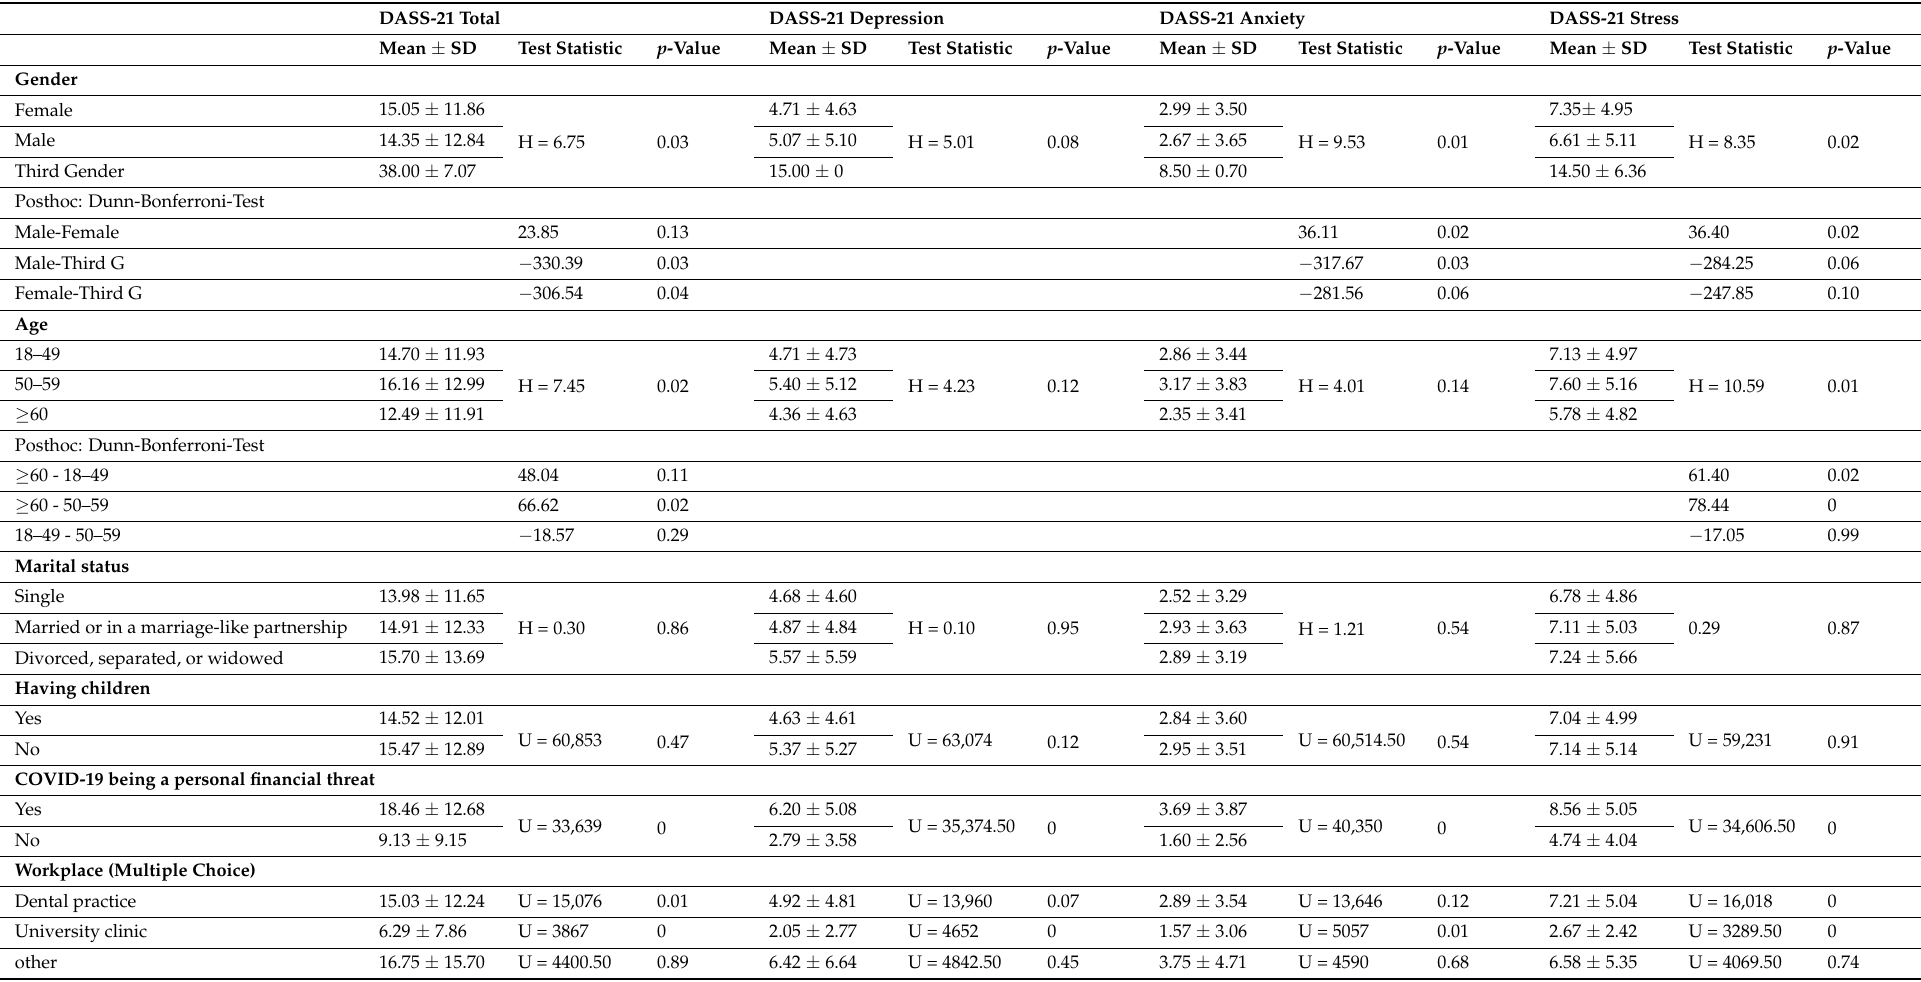
Table 4. Differences between participants characteristics regarding DASS-21 total and subscale